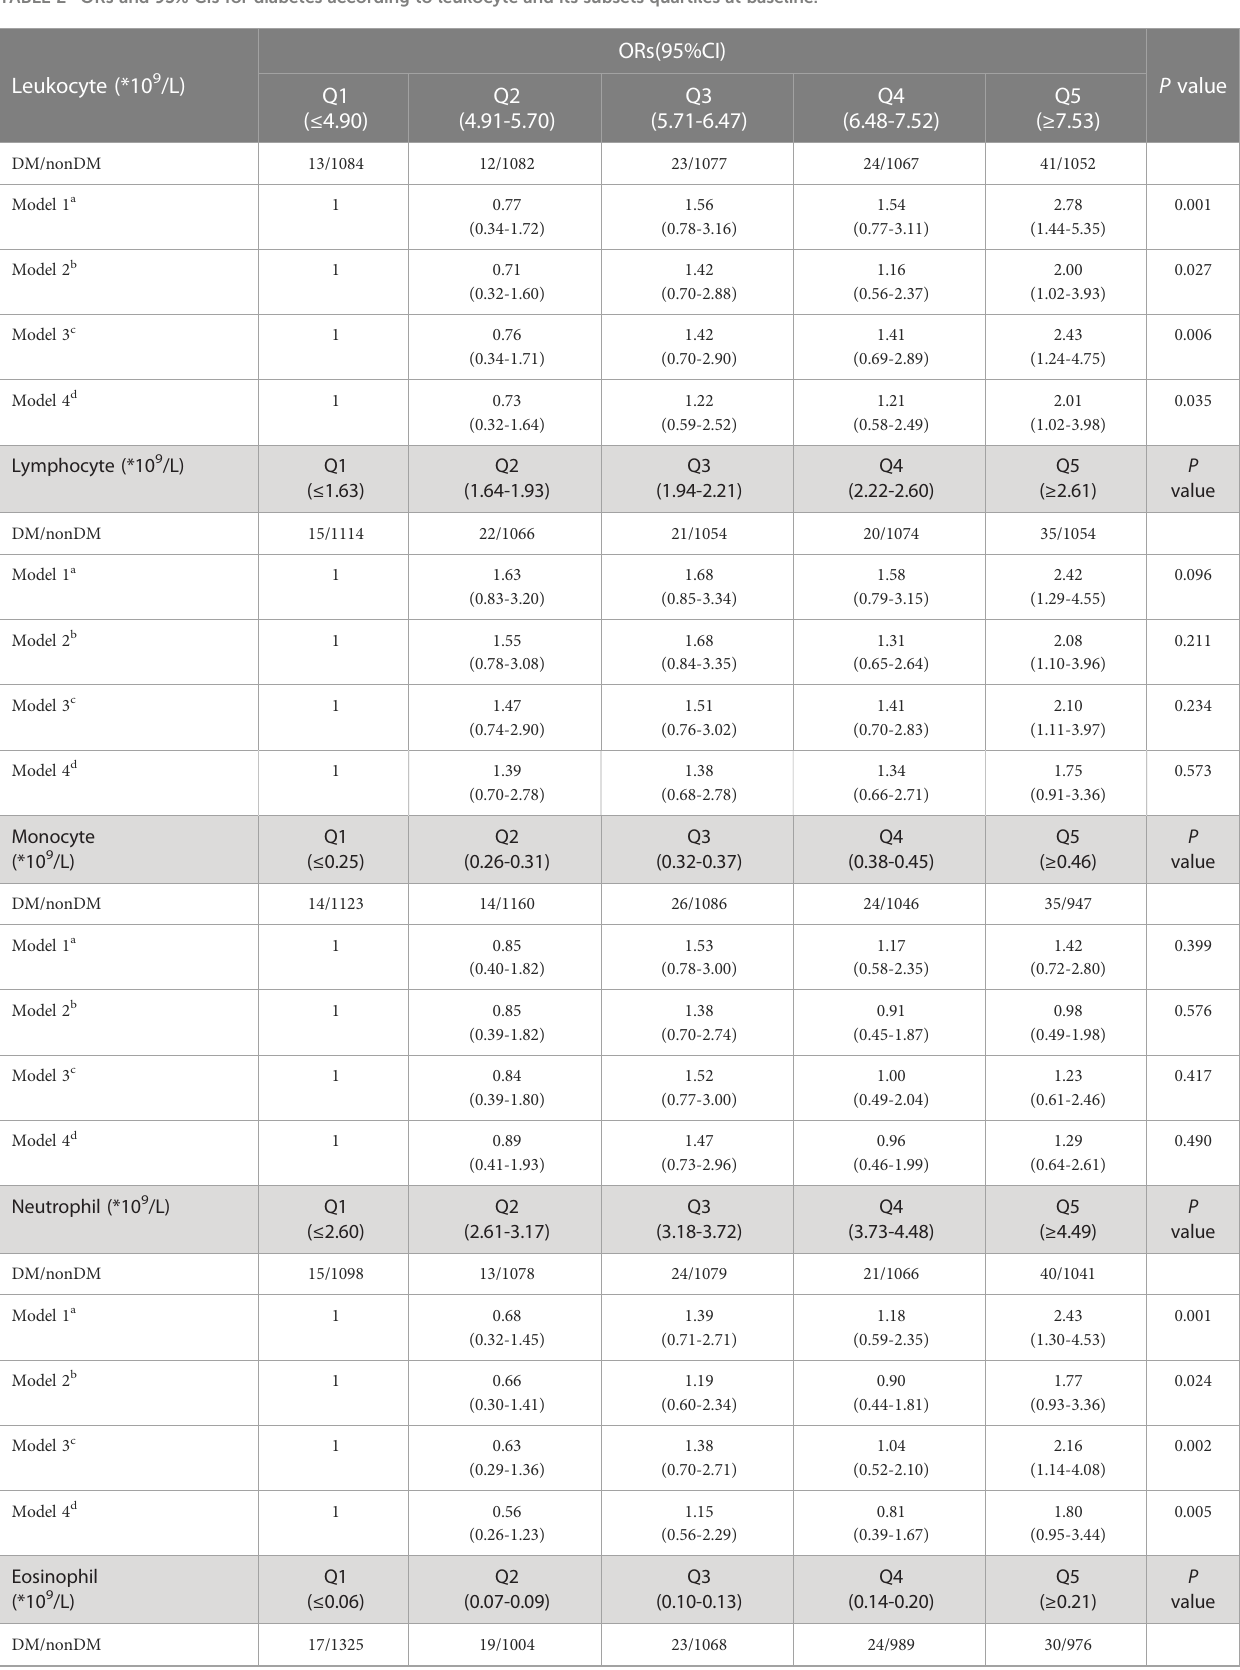
TABLE 2 ORs and 95% CIs for diabetes according to leukocyte and its subsets quartiles at baseline.